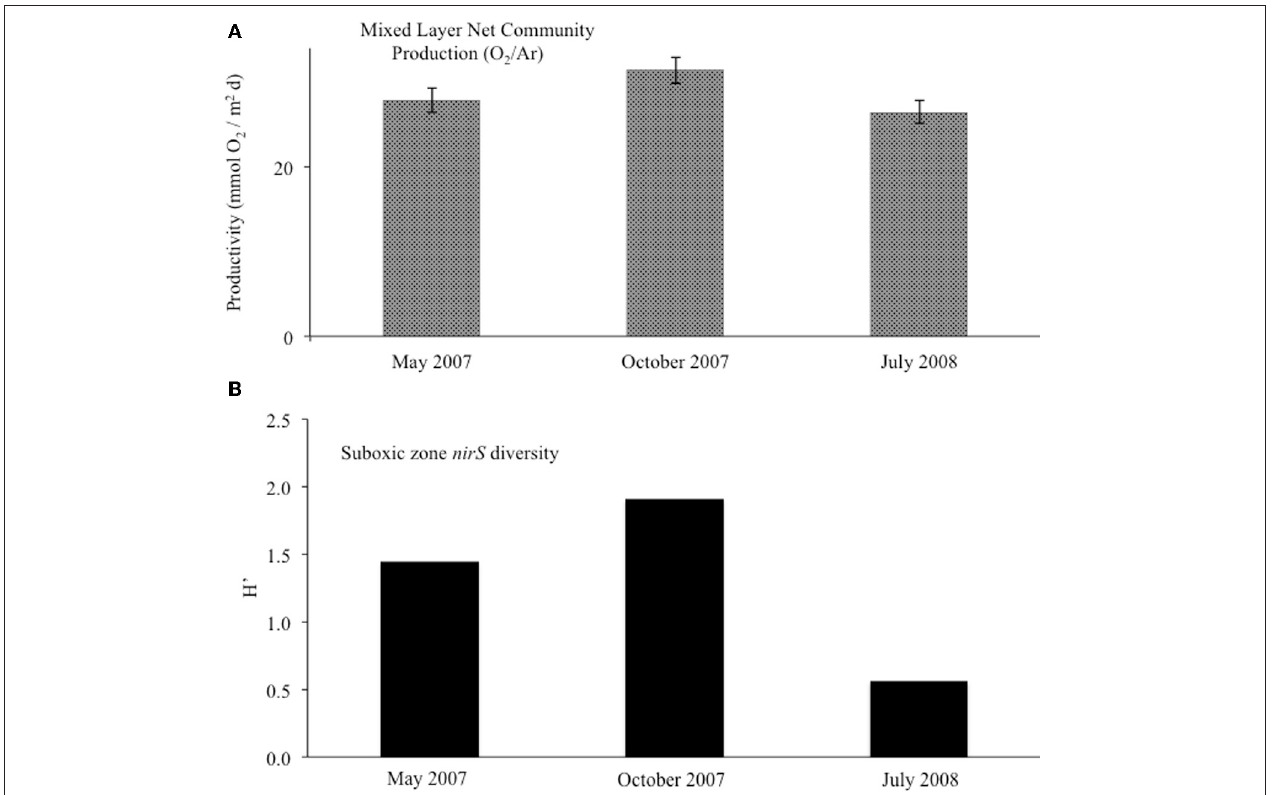
FIGURE 9 | (A) For the surface mixed layer, net community productivity calculated with O 2 /Ar measurements. Error bars for NCP were calculated from averages of mixed layer O 2 /Ar ( n = 4). (B) Suboxic zone (15 . 6 ≤ σ θ ≤ 16 . 0) clone library diversity, as calculated with the Shannon-Wiener